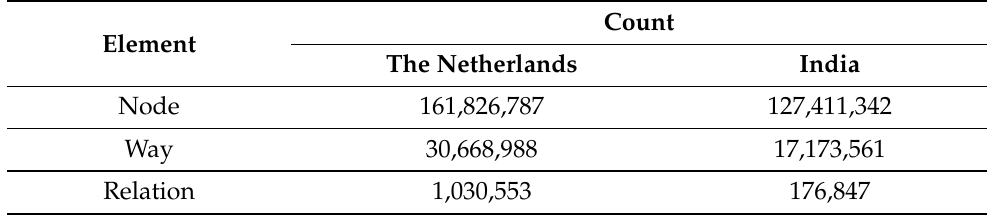
Table 2. Element count of the Netherlands and India (snapshot 15 October 2019) [40]. By comparing the numbers of elements, it is clear that the data density of the Netherlands is much higher compared to that of